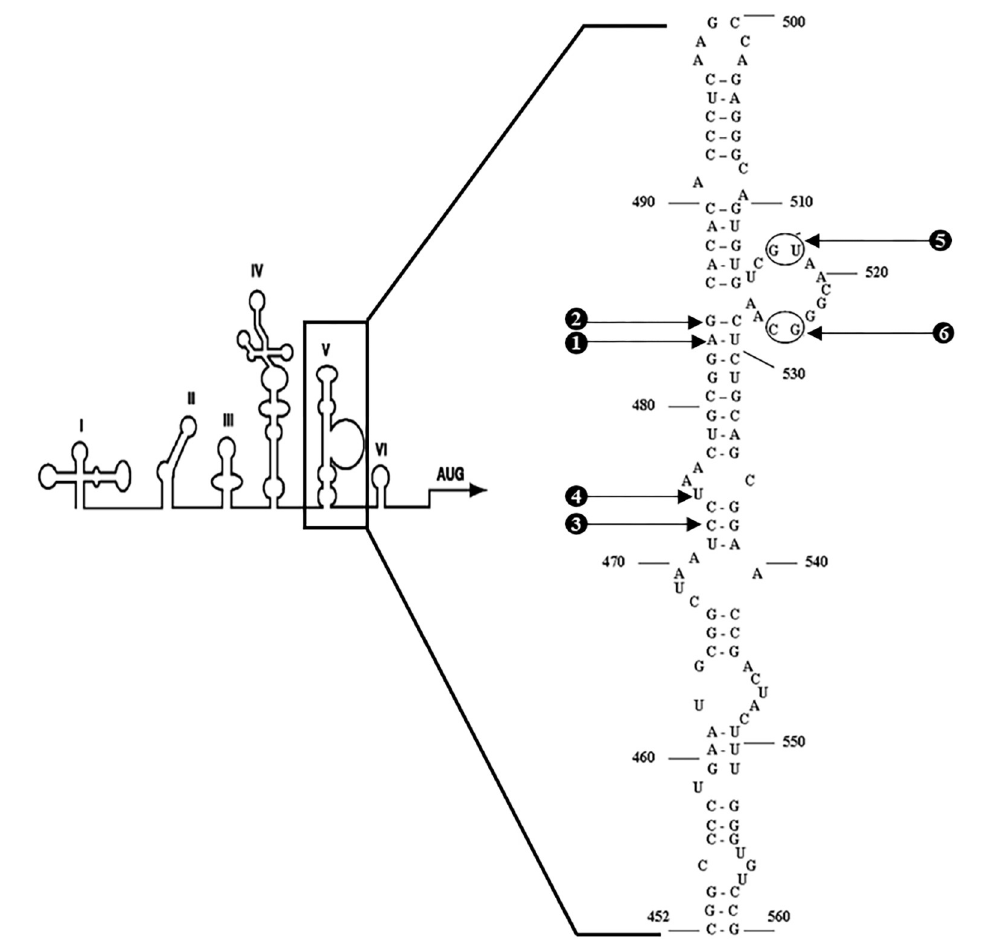
Fig 1. Structure and sequence of domain V of CVB3 IRES. Position of introduced mutations (1–6) on IRES domain V producing CVB3 mutants (M1 to M6) are indicated.